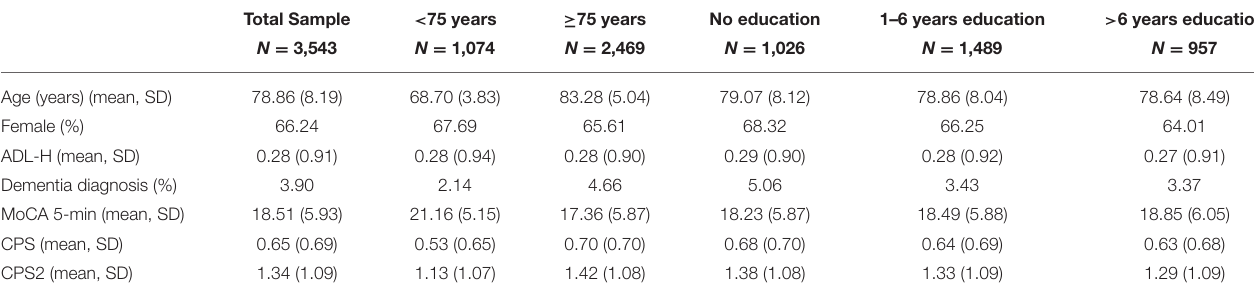
TABLE 1 | Sample characteristics.